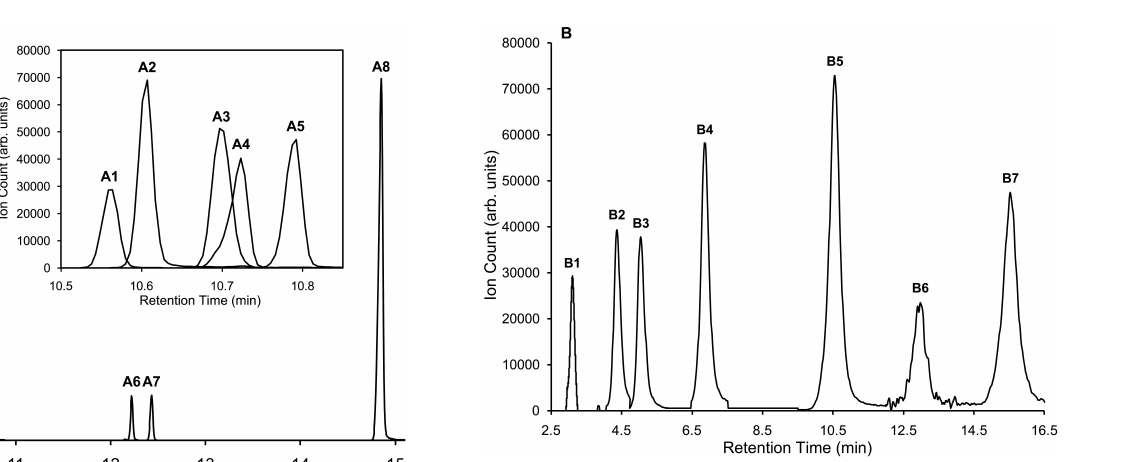
Fig. 2b. Chromatogram from a derivatized mixture of amines an- alyzed by LC/MS. (B1) , methylamine ( m/z 198); (B2) , morpho- line ( m/z 254); (B3) , dimethylamine ( m/z 212); (B4) , ethylmethy- lamine ( m/z 226); (B5) , diethylamine ( m/z 240); (B6) , aniline ( m/z 260); (B7) , n -butylamine ( m/z